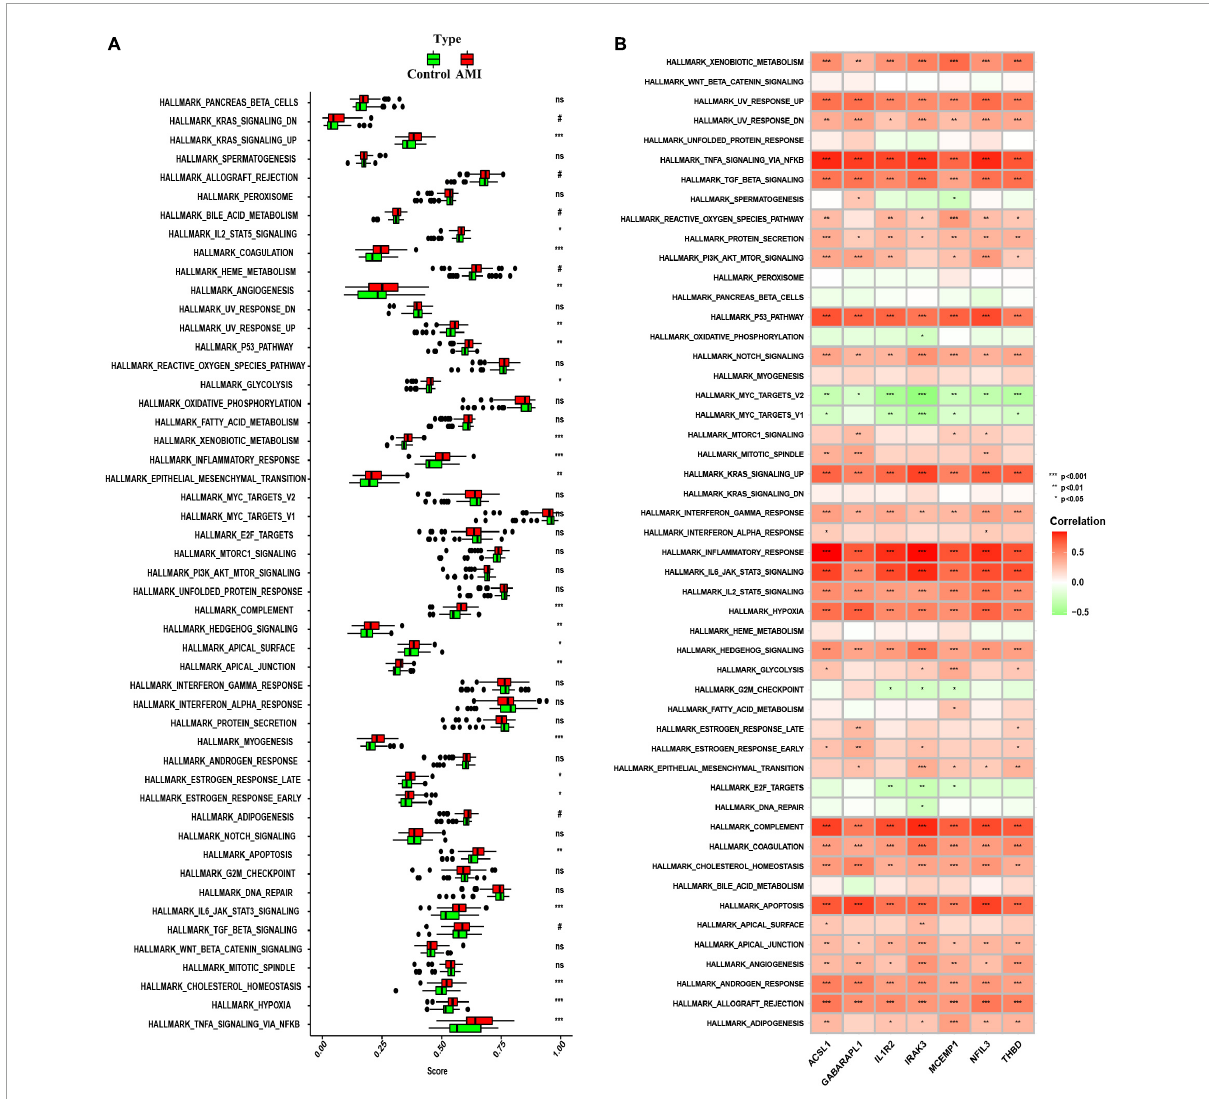
FIGURE10 Analysis of hallmark gene sets. (A) The specific distribution of the 50 hallmark gene sets in AMI and control samples. (B) Correlation analysis of the 50 hallmark gene sets with seven optimal feature genes. Statistic tests: Wilcoxon rank-sum test ( P < 0.2 # ; P < 0.05*; P < 0.01**; P < 0.001***; ns, no